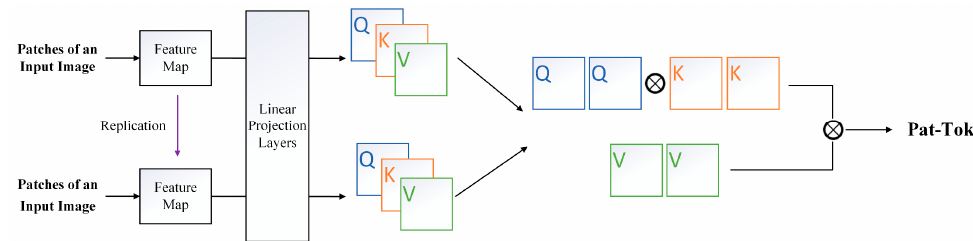
Figure 6. The structure of CAM. Q: query, K: key, V: value.